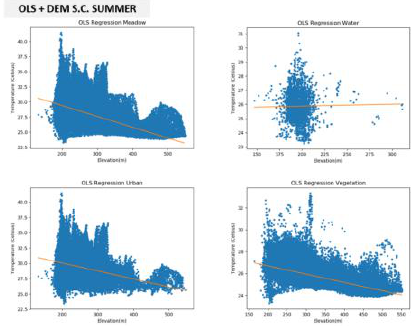
Figure 23: OLS Regression Model in Summer (Temperature – Land Cover - DEM)